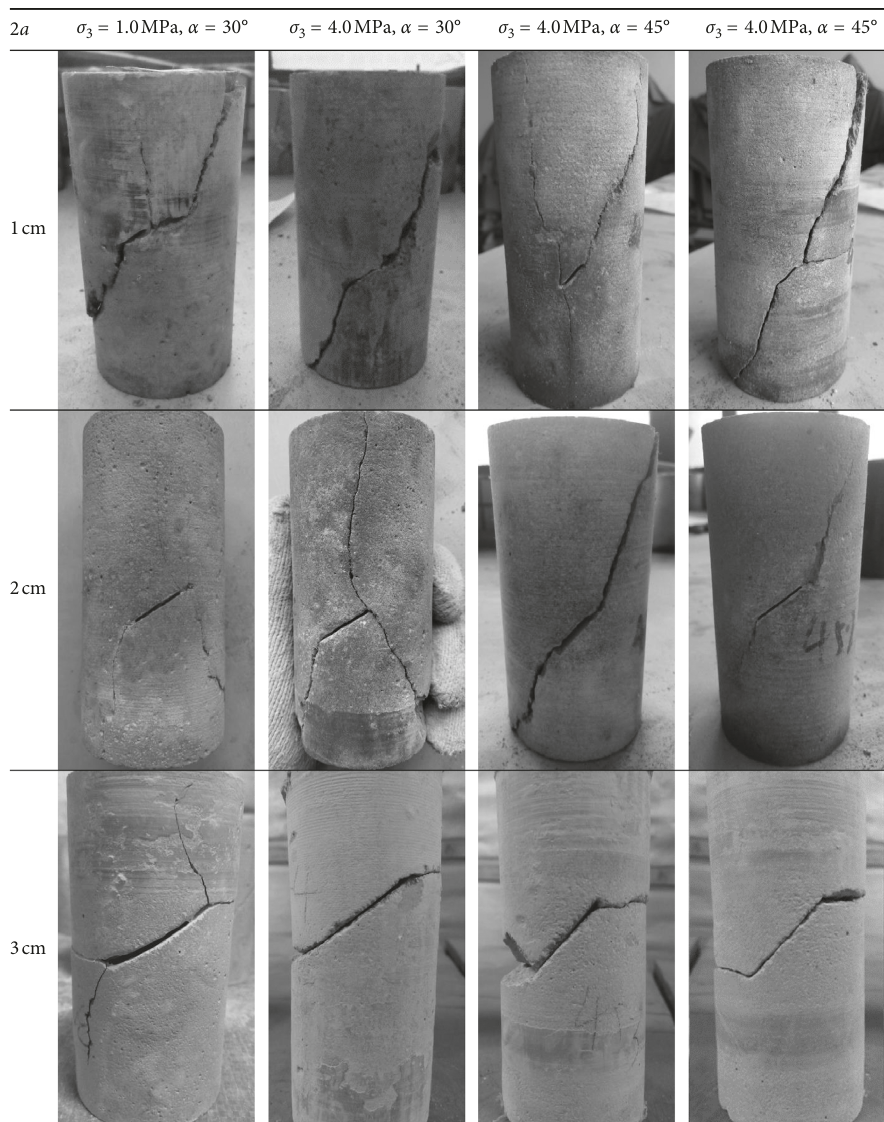
Figure 10: Failure modes of the specimens with an unfilled flaw at σ